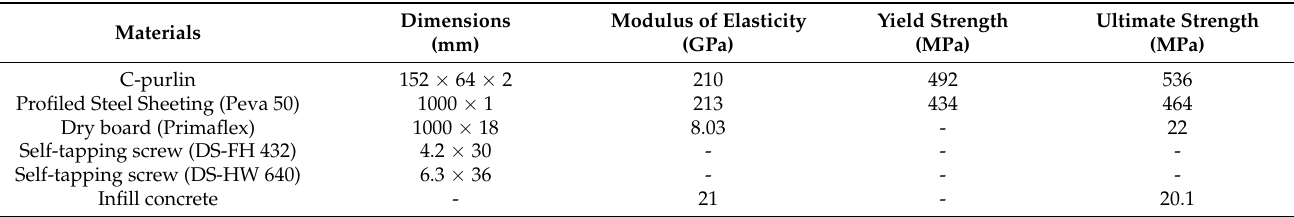
Table 2. Physical properties of